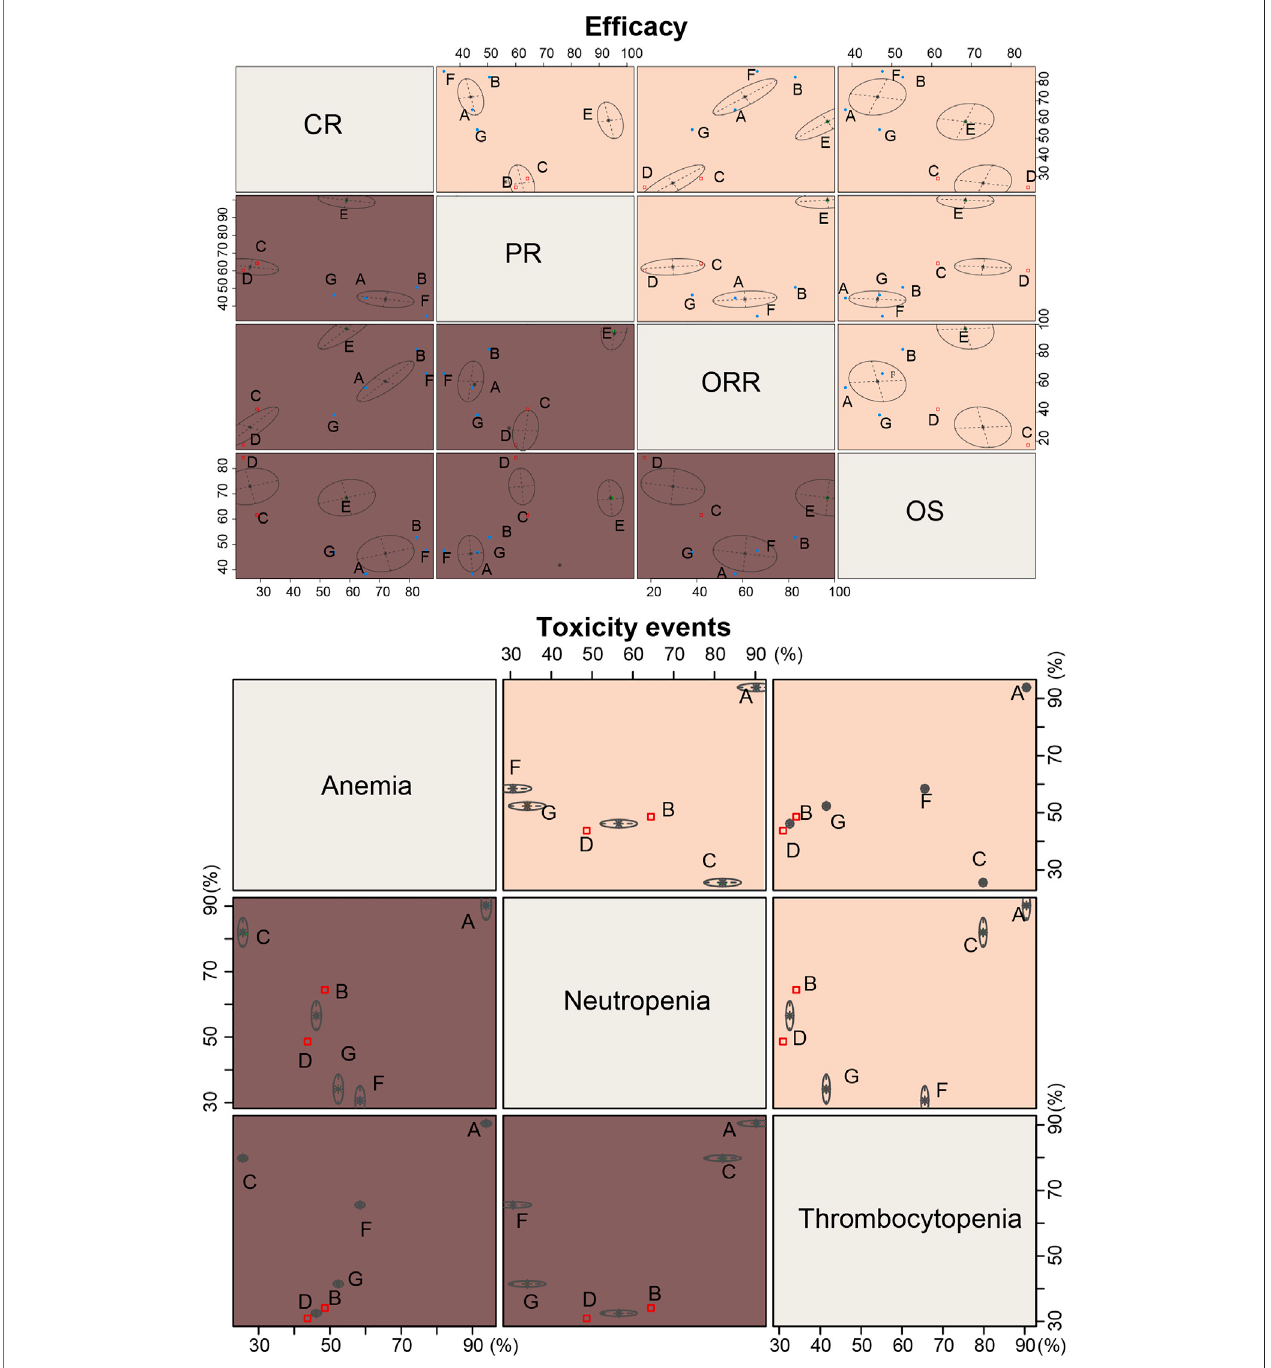
FIGURE 6 | Cluster ranking plots based on SUCRA ef fi cacy and toxicity values of seven chemotherapy regimens for HL. A (cid:1) ABVD (doxorubicin + bleomycin + vinblastine + dacarbazine); B (cid:1) BEACOPP (bleomycin + etoposide + doxorubicin + cyclophosphamide + vincristine + procarbazine + prednisone); C (cid:1) Stanford V (doxorubicin + vinblastine + mechlorethamine + vincristine + bleomycin + etoposide + prednisone); D (cid:1) MOPP (mechlorethamine + vincristine + procarbazine + prednisone);E (cid:1) COPP+ABVD(cyclophosphamide+vincristine+procarbazine+prednisone+doxorubicin+bleomycin+vinblastine+dacarbazine);F (cid:1) MOPP+ ABV (Hybrid) (mechlorethamine + vincristine + procarbazine + prednisone + doxorubicin + bleomycin + vinblastine); G (cid:1) MOPP + ABVD (Alternating).